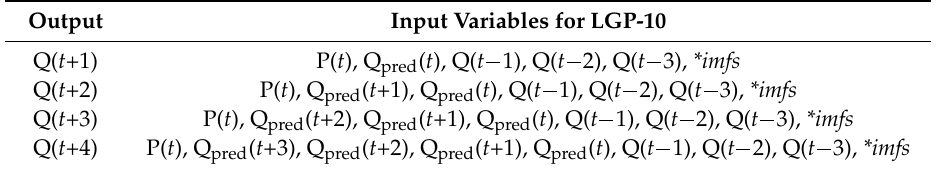
Table 4. Output and Input variables for EEMD-SOM-LGP models designed to predict ahead